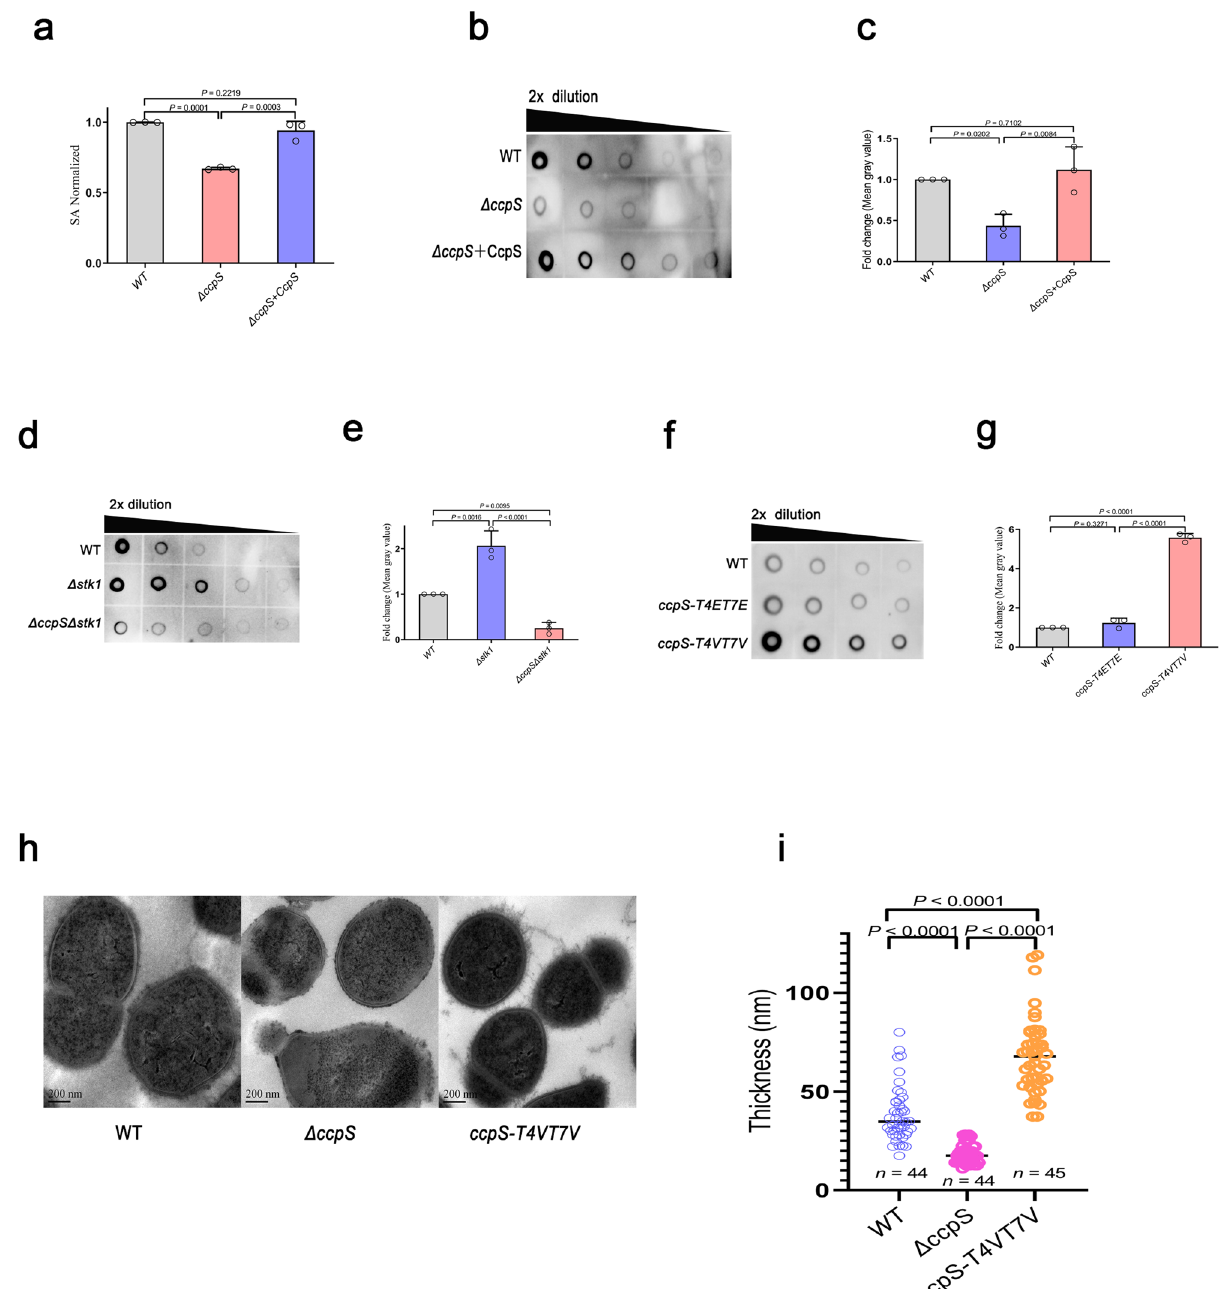
Fig.3|CcpSmediatesthecapsularpolysaccharidesynthesis,andtheactivityof CcpS is tuned by phosphorylation. a Bar graph showed the cell surface ’ s